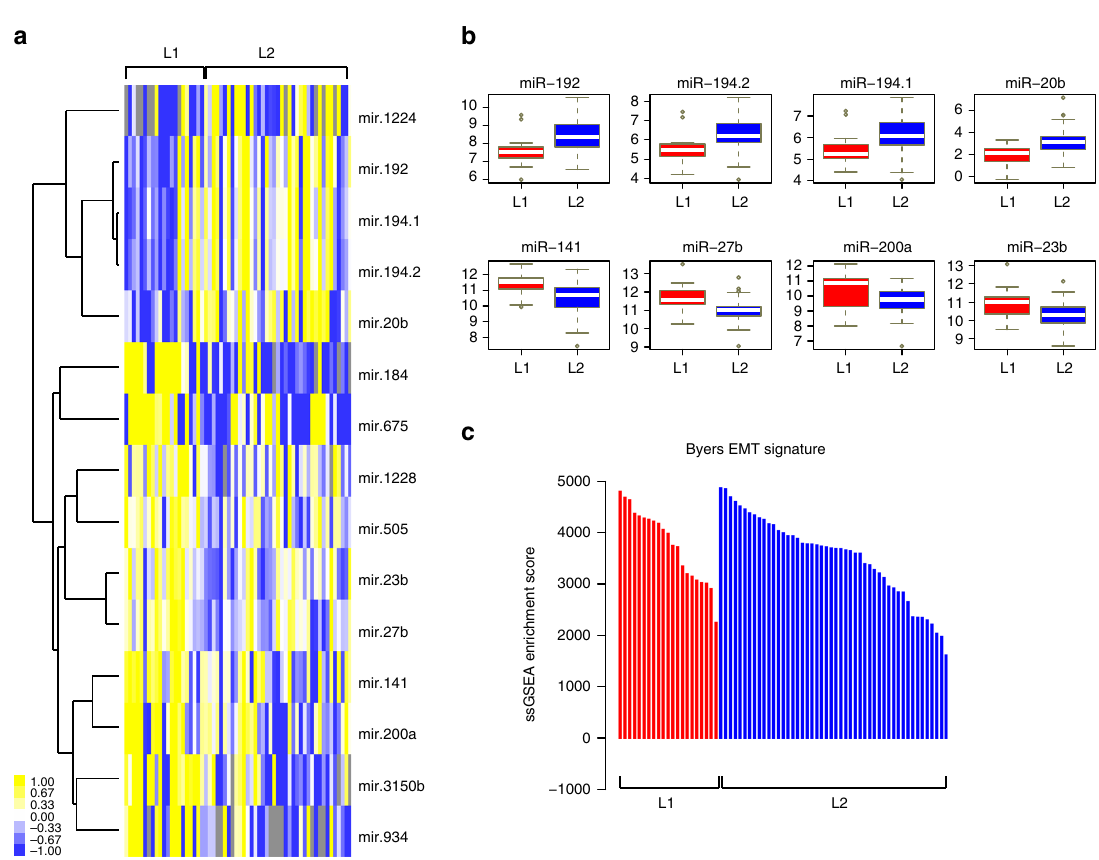
Fig. 5 Enrichment pro fi les of EMT signatures and microRNAs in L1 and L2. a Heatmap showing miRNAs with signi fi cant differences in expression pro fi le between the L1 and L2 clusters. Blue indicates underexpression, yellow indicates overexpression, and gray indicates expression data not available. b Box plot showing the normalized gene counts (reads per million miRNA mapped) of miRNAs that are over- or underexpressed in L1 clusters of laryngeal tumors. X -axis indicates the L1 and L2 clusters, while the Y -axis indicates normalized gene counts of miRNA for both L1 (blue box) and L2 (red box) samples. c Waterfall plot depicting the enrichment score for each laryngeal tumor against a gene set of 76 genes forming an EMT signature as de fi ned by Byers et al. 15 , using the ssGSEA algorithm. Blue and red bars indicate tumors in L1 and L2 clusters, respectively. Y -axis shows the enrichment scores. A positive enrichment score indicates the extent to which genes in EMT signature are overexpressed in each tumor sample. Similarly, a negative enrichment score indicates the extent to which genes in EMT signature are downregulated in the tumor